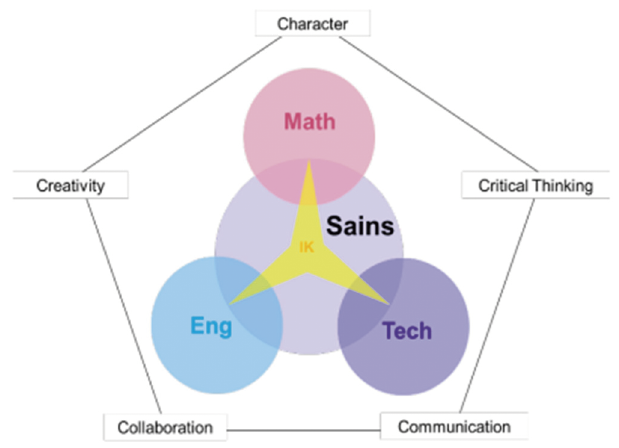
Figure 1. PjBL-Ethno-STEM